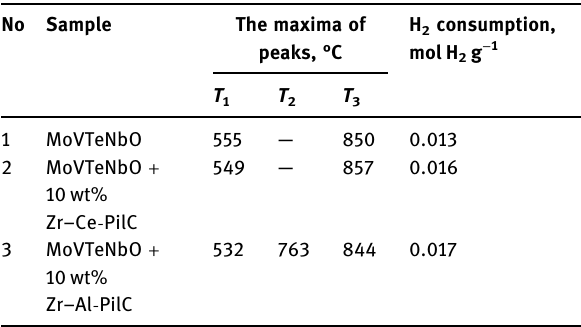
Figure 8: H 2 - TPR curves for bulk PilC, MoVTeNbO oxide, and its composites with 10 wt% of pillared clays.